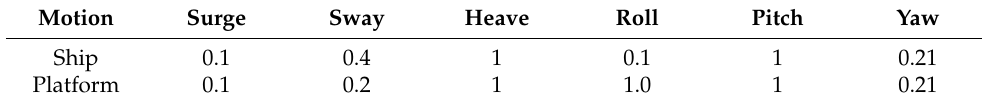
Table 6. The added mass coefficients of the supply ships and the platforms.